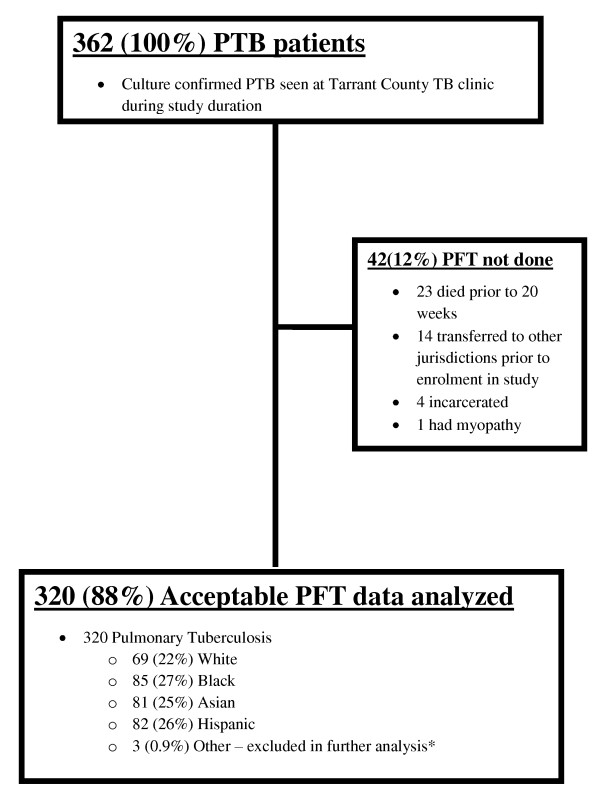
Study enrolment.